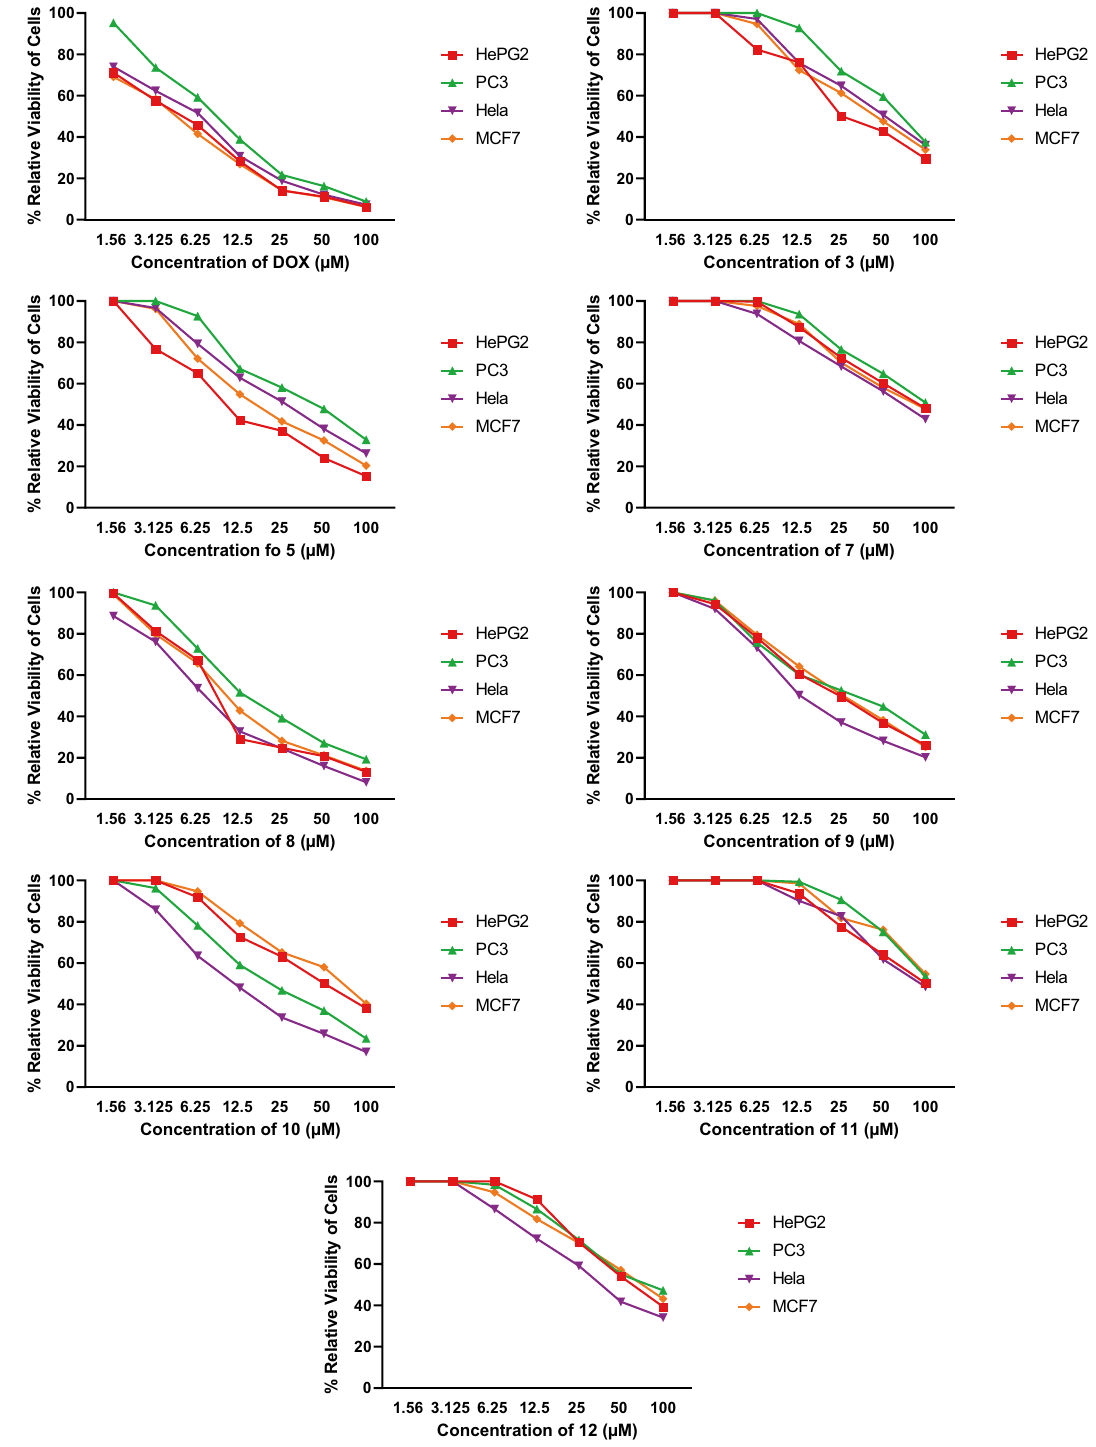
Figure 3. Survival curves of the tested compounds 4 , 5 , 7 – 12